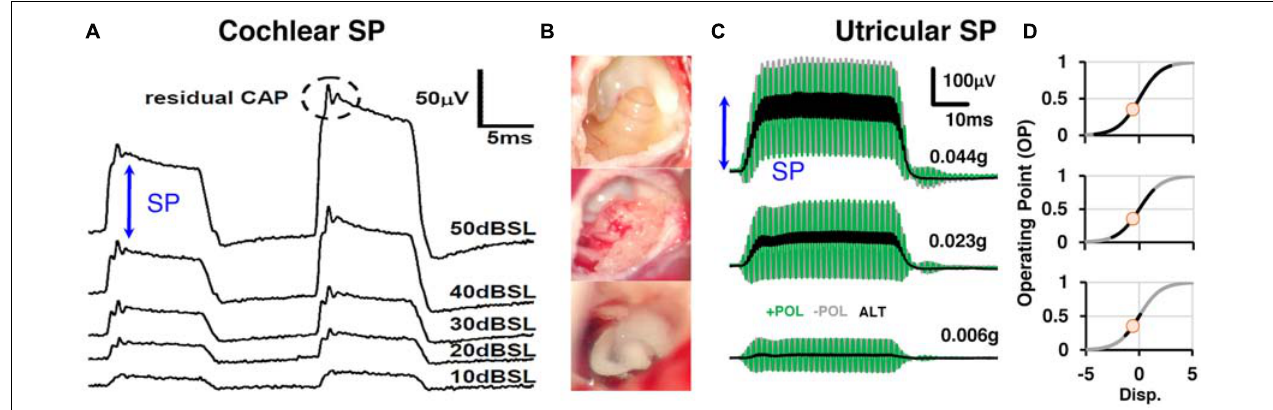
FIGURE 8 | (A) Sound-evoked responses recorded simultaneously from scala tympani and scala vestibuli subtracted from one-another to produce differential (DIFF) responses, which is an approximation of the cochlear Summating Potential. DIFF waveforms were evoked by 18 kHz and 20 kHz tone-bursts at a range of sound levels (10–50 dB SPL). Reproduced (adapted) from ‘Origins and use of the stochastic and sound-evoked extracellular activity of the auditory nerve’. Pg. 162. Doctoral Thesis. The University of Western Australia. Daniel Brown. 2006. With permission from Copyright owner Daniel Brown. (B) In order to record utricular SPs, a ventral surgical approach is needed to surgically ablate the cochlea and expose the utricular macula for localized recordings on the macular surface. (C) Utricular SPs were evoked by alternating BCV stimuli at moderate to intense levels of BCV (0.023 – 0.044 g). (D) The generation of SPs were modeled by modulating the MET transducer current into asymmetric (high-slope) regions of the gating profile (first-order Boltzmann function). Reproduced (adapted) from Pastras et al. (2021). Copyright Elsevier (Hearing